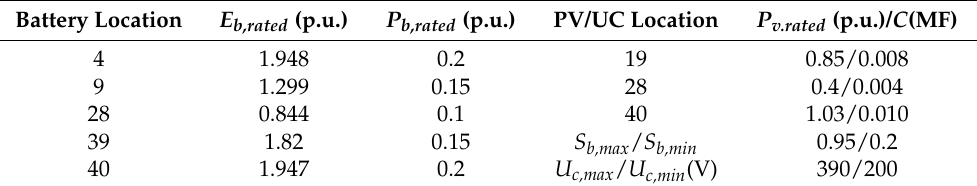
Table 3. Parameters of PV and HESS.